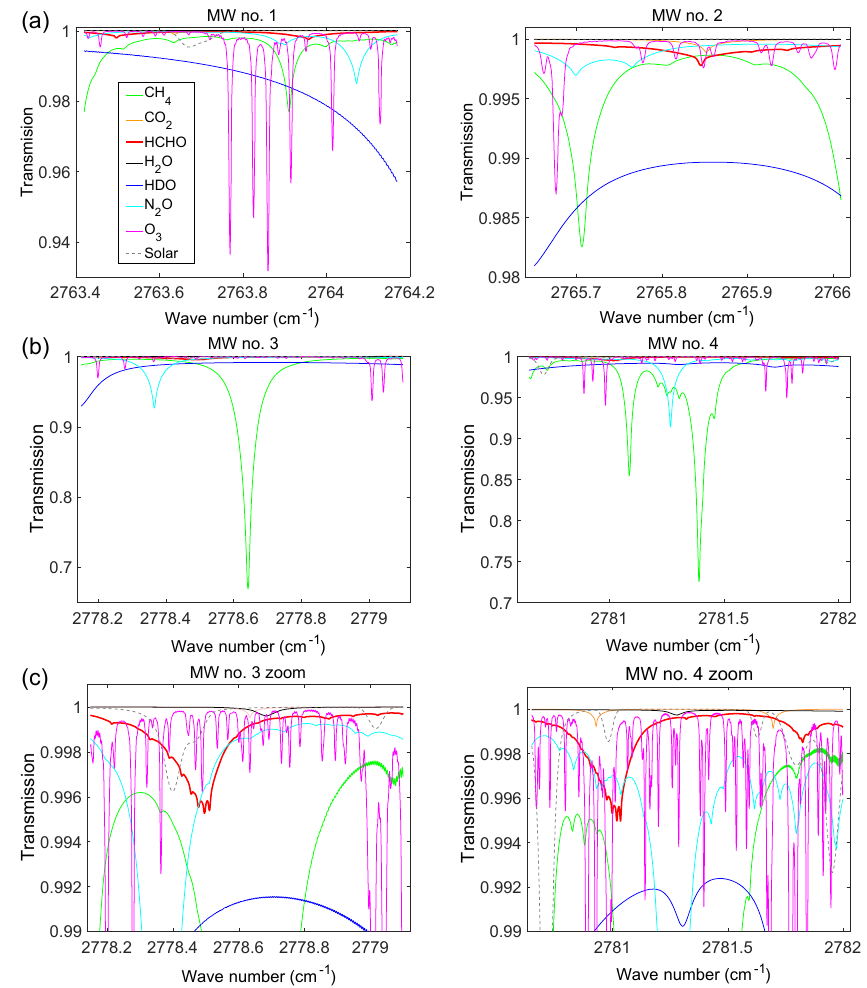
Figure 2. Retrieved contributions of all fitted species in the four MWs (a, b) used in the analysis for a spectrum recorded on 12 February 2014 at Maïdo and corresponding to a retrieved HCHO total column of 2 . 48 × 10 15 moleccm − 2 . Panels (c) are magnifications of the MWs nos. 3 and